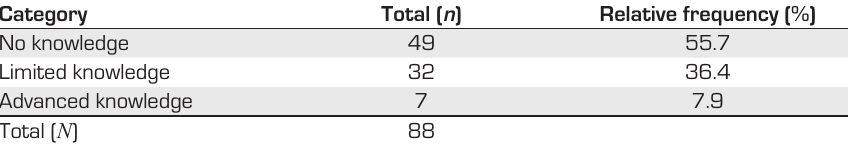
TABLE 3: Initial categories.